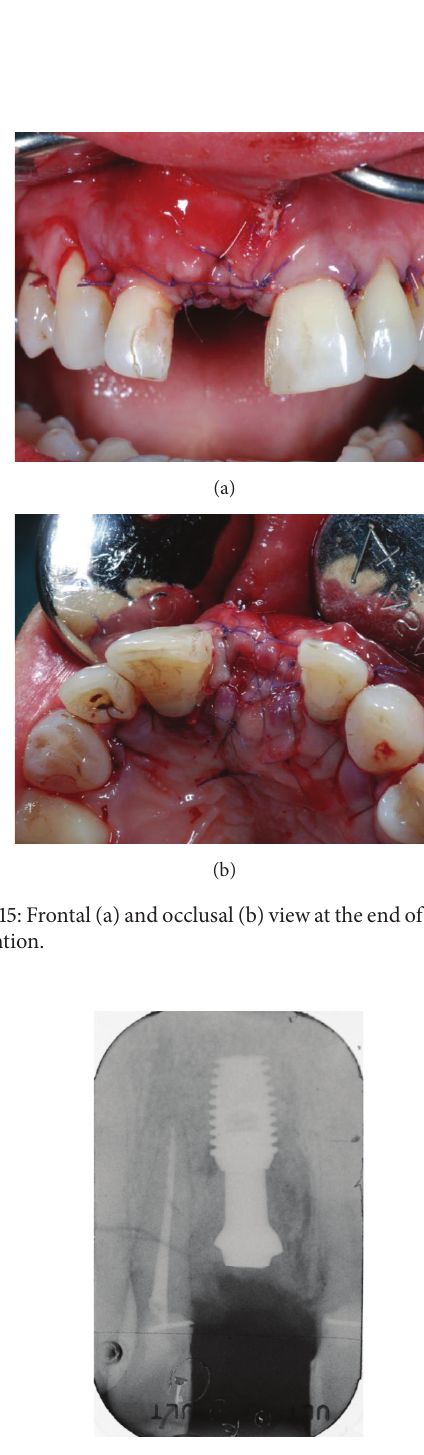
Figure 16: Postoperative X-ray shows fulfilling of the defect, with the implant lying in native bone below the grafted